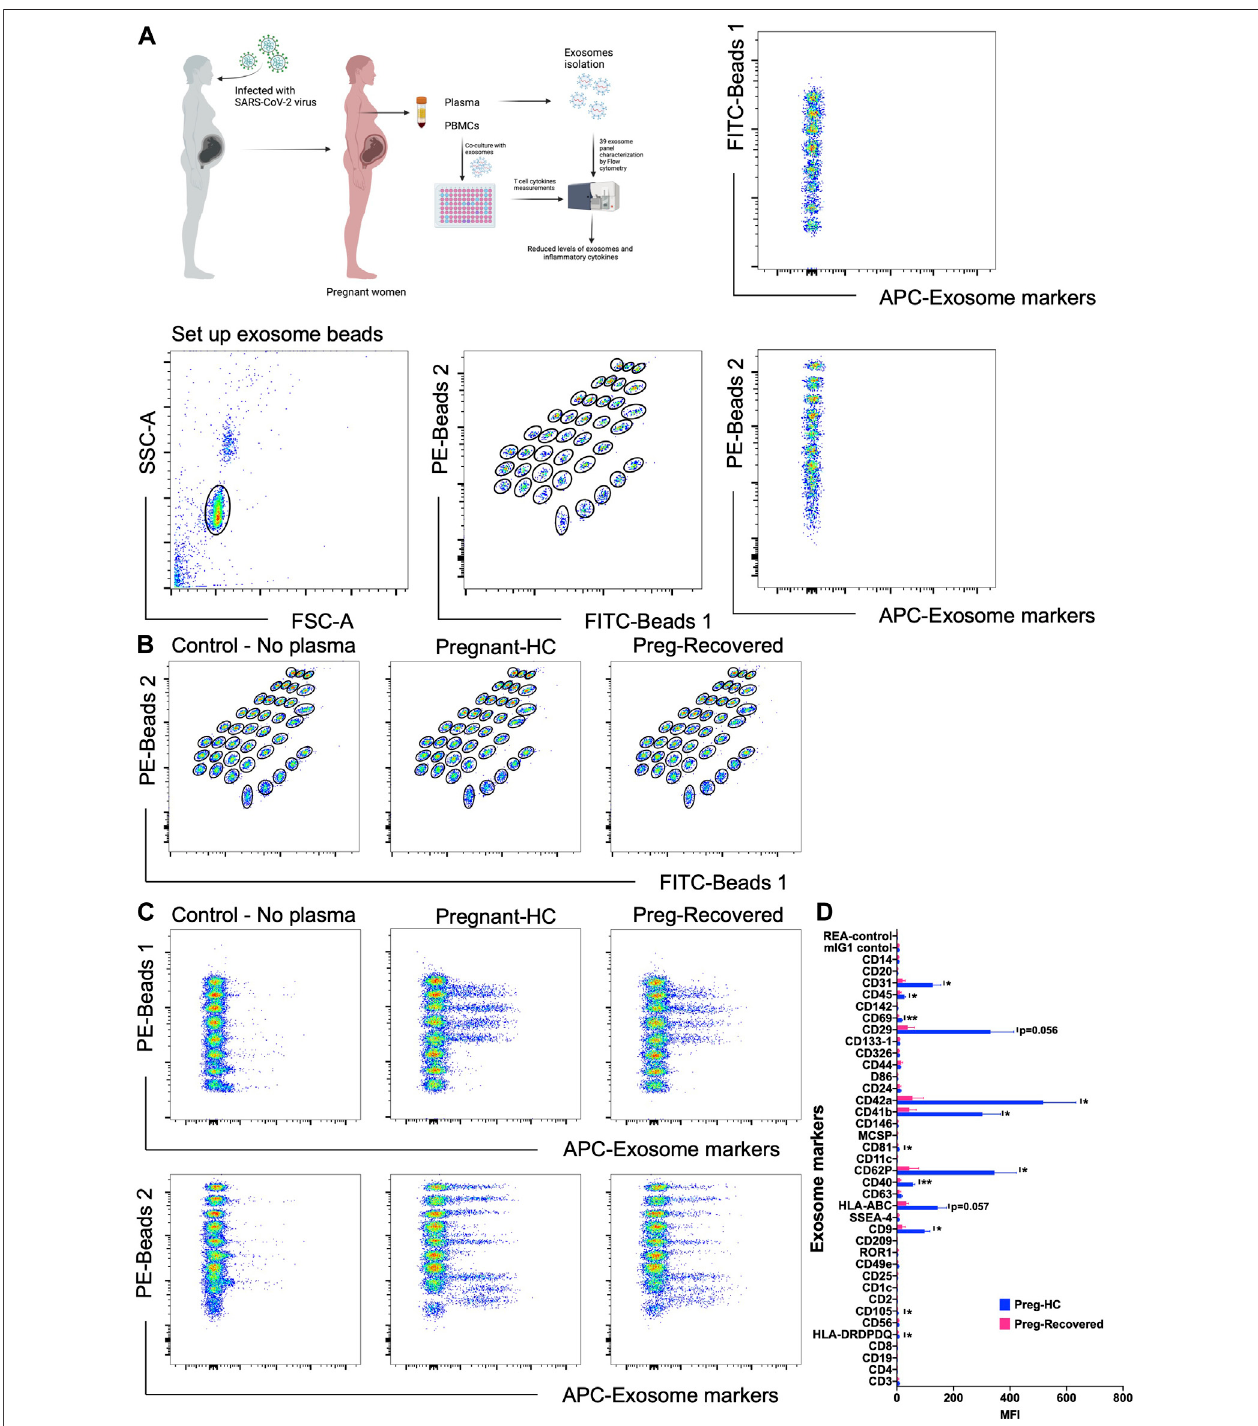
FIGURE 1 | Detection of exosomal levels in COVID-19-recovered pregnant women. (A) Schematic picture showing the experimental strategy for the detection of exosomelevelsand invitro immuneresponseinPBMCs(left).Themultiplexbead-basedplatformwasusedforthedetectionofexosomelevels.Isolatedexosomeswere incubatedfor1 hwith39differentbeadpopulations.Thedifferentbeadpopulationsaredistinguishableby fl owcytometry.Exosomesboundtothebeadsweredetected by using an equal volume of the exosome markers including 39 exosomal markers anti-CD9-APC, CD63-APC, and CD81-APC antibodies. The gating strategy applied for gating on single beads and showing exclusion of doublets and no bead events. The subsequent gates applied to identify all 39 capture beads show their fl uorescence inthe FITC vs .PEchannelwithadjunct dotplots showingrespectiveAPC-stained bead populations. (B,C) Gates applied toidentifythe 39distinct capture